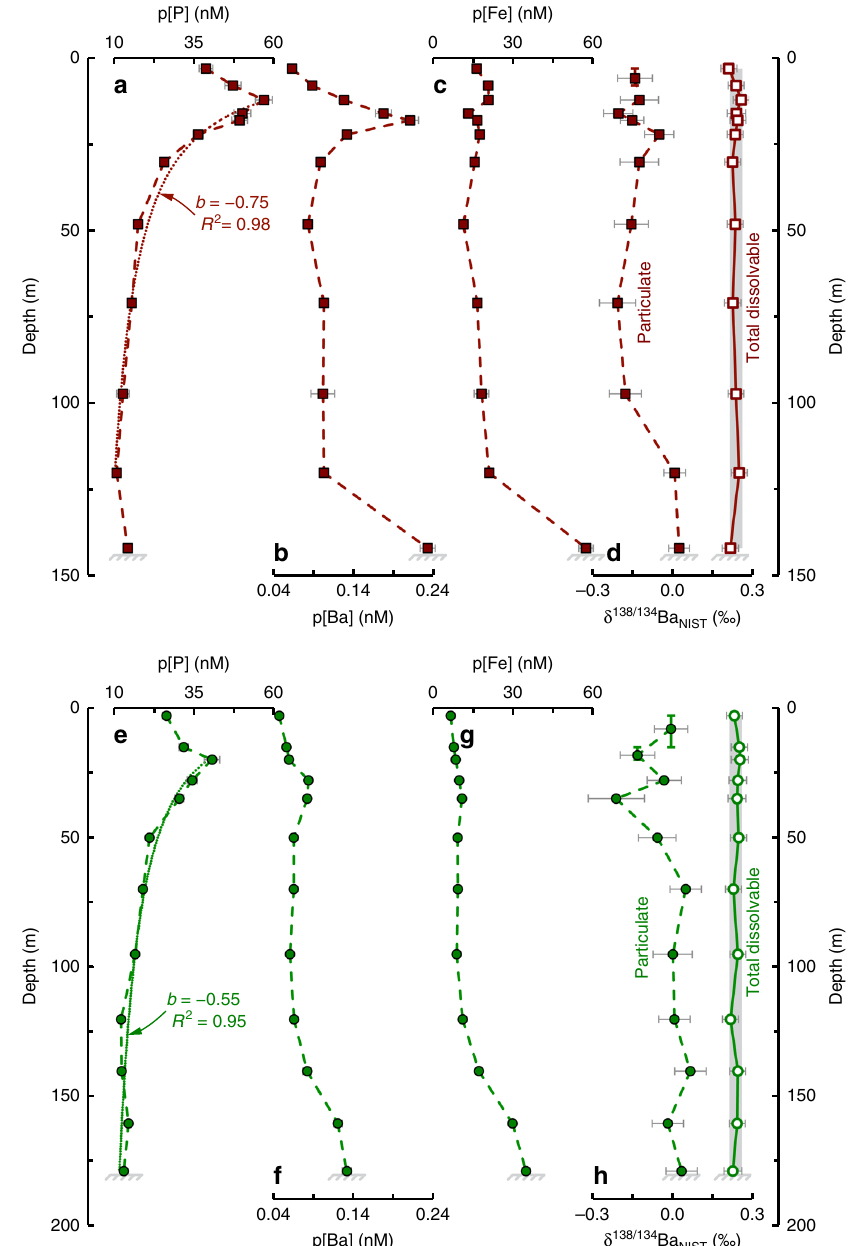
Fig. 2 Multi-element geochemistry from Lake Superior. Particulate data were obtained by fi ltering between 0.5 – 3.0 L of Lake Superior water through a 0.45 μ m polyethersulfone membrane fi lter immediately after collection. a – d from St. FWM; e – h from St. WM; dashed and solid lines show particulate and dissolved samples, respectively. Vertical error bars on the shallowest samples in d , h denote depth ranges over which particulate samples were pooled to obtain suf fi cient Ba for isotopic analysis. Horizontal error bars for any given property measurement re fl ect the propagated 2 × SD uncertainty. Thin dotted lines in a , e illustrate power-law fi ts to p[P] pro fi les 28 , excluding the benthic nepheloid layer sample from FWM (see text). Total dissolvable [Ba] and Ba-isotopic compositions are uniform for both stations at 69.7 ± 1.4 nM and +0.23 ± 0.02 ‰ , respectively ( ± 2 SD; n = 24); pBa